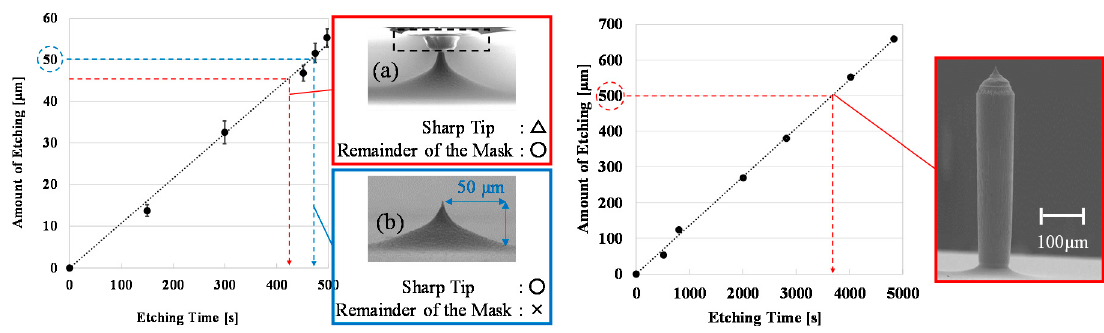
Figure 4. Relationship between the amount of etching and etching time.